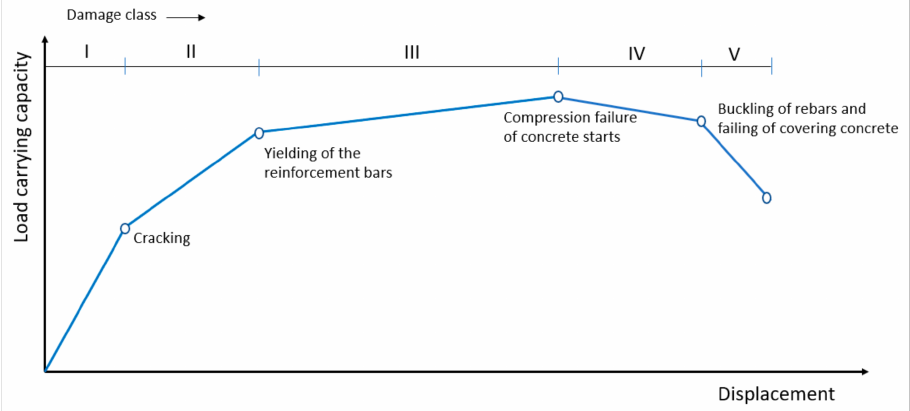
Figure 1. Idealized lateral forced-displacement relationships and damage class for ductile member